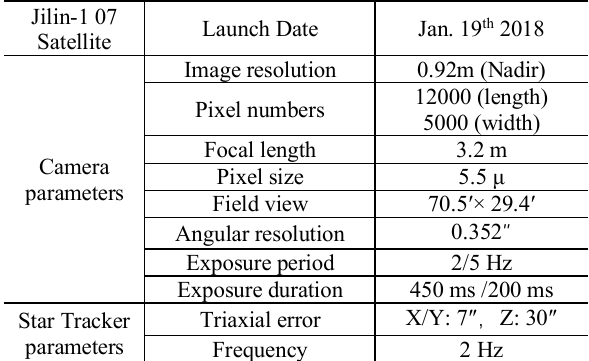
Table 1 . The introduction of Cam-ST of Jilin-1 video satellite. There are two satellite star observation tasks, which were taken on October 26 th and November 13 th , 2020. The video camera is taken in a circle of orbit, with a time interval of 10 minutes and a latitude of approximately 36°. The camera works 10 times in each task, each time the camera is aimed at the same stellar area. Satellites keep their attitude unchanging in the inertial system when imaging stars. Among them, the camera of task 101~110 shoots for 6s each time, and exposes for 200ms per video frame.